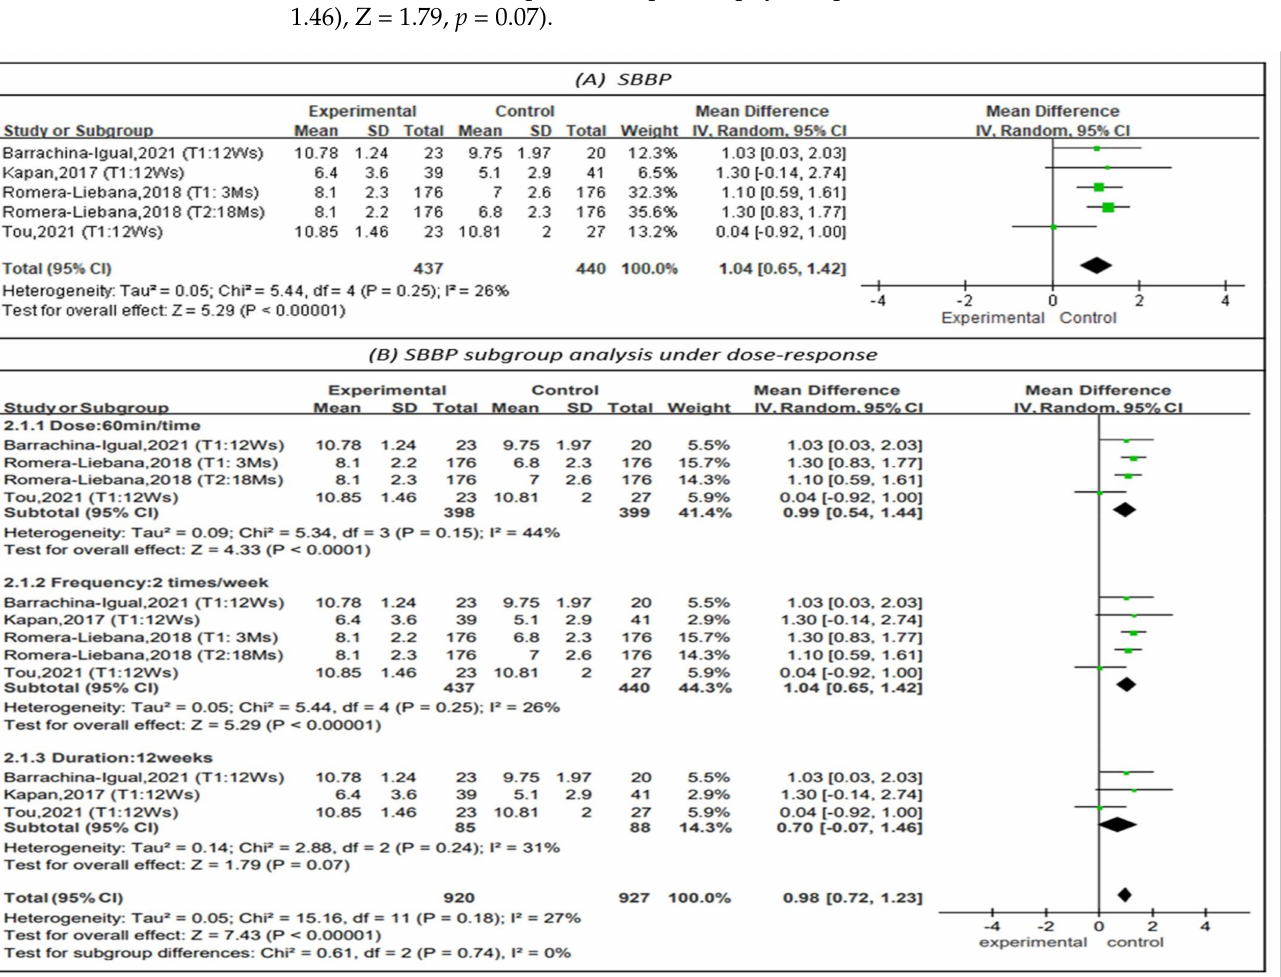
Figure 4. Forest plot of effects on SBBP and subgroup analysis for dose-response. The size of the green square represents the weight of the study in the meta-analysis. The rhombus represents the combined OR. OR = odds